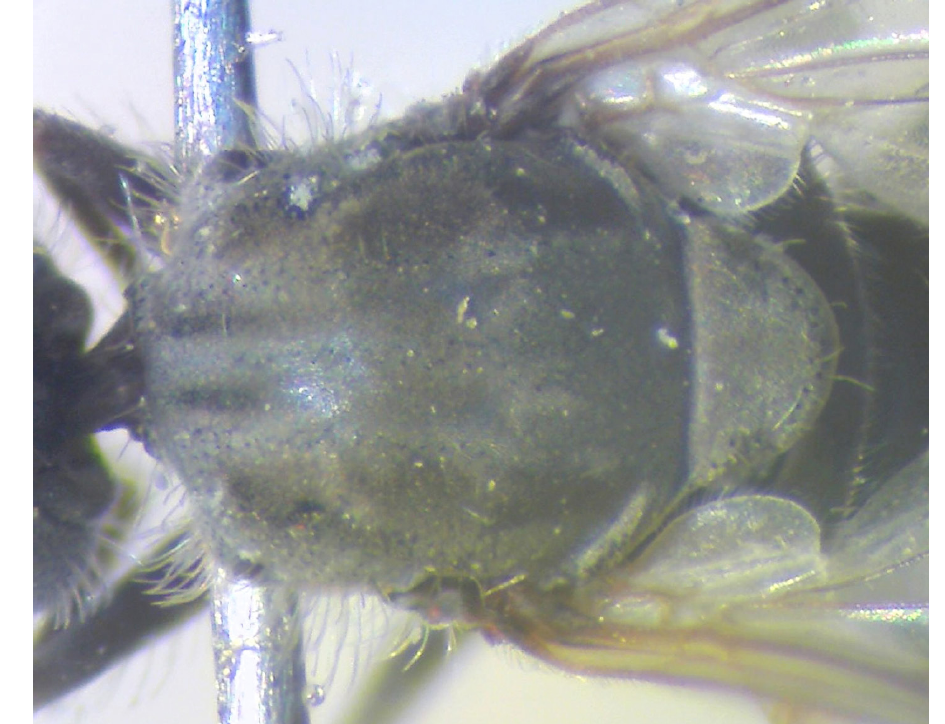
Fig. 10. Protypusia negevi (Zaitzev, 1996) gen. et comb. nov., ♂.